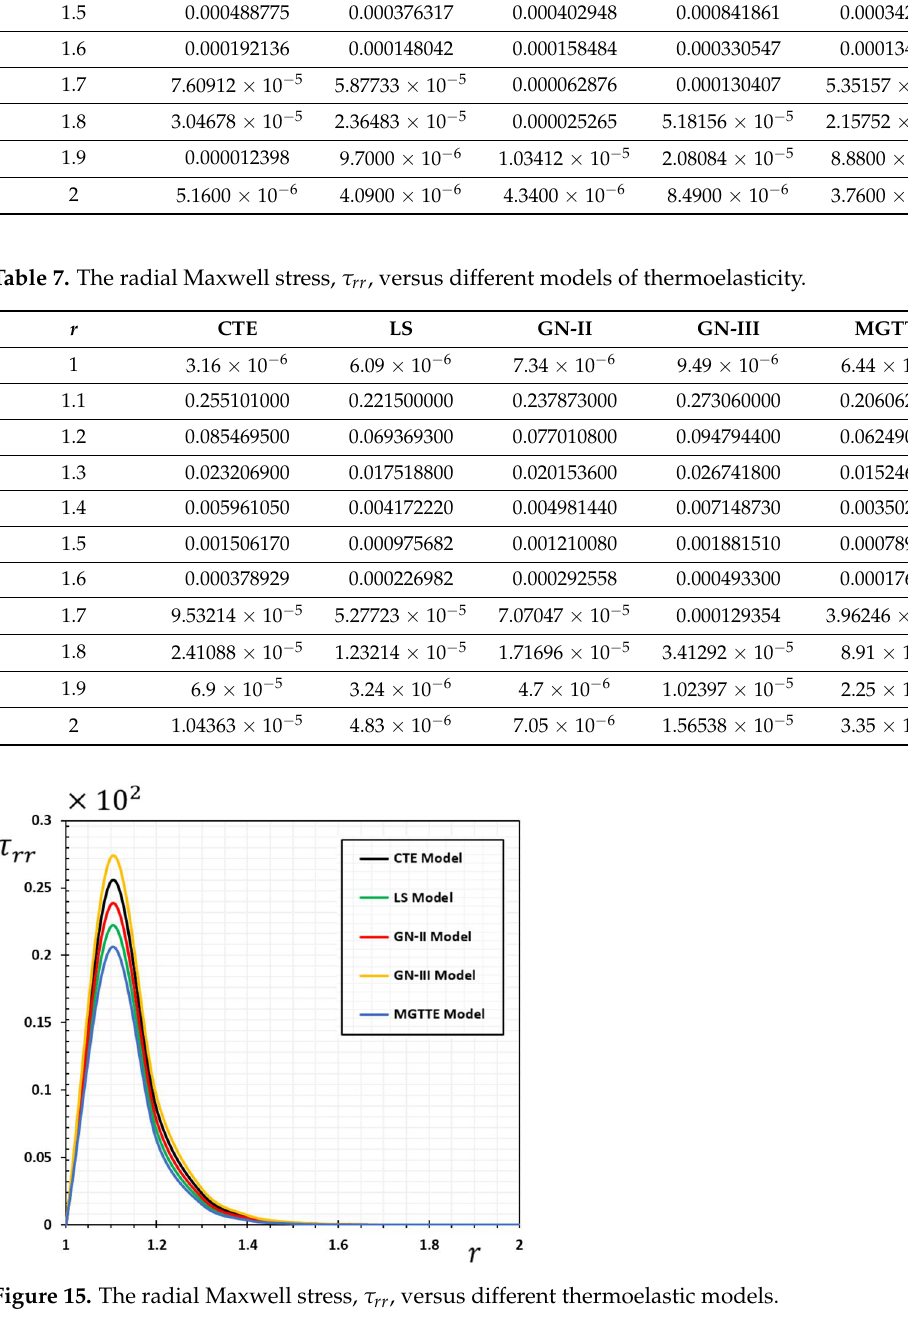
Table 7. The radial Maxwell stress, (cid:2028) (cid:3045)(cid:3045) , versus different models of thermoelasticity.